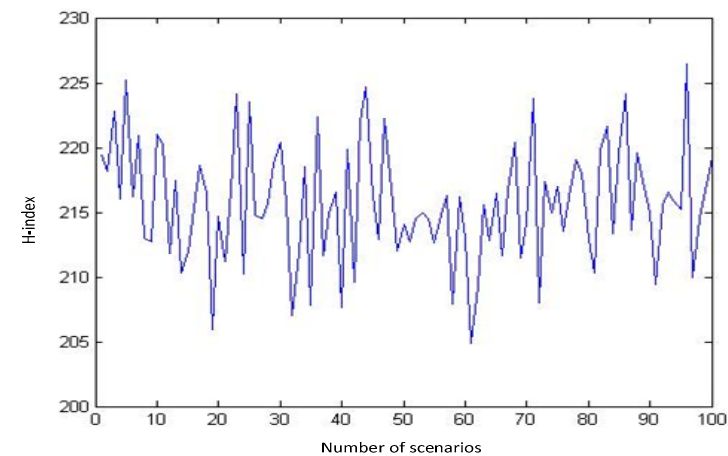
Figure 3. One hundred randomly generated scenarios and their related H-indexes.